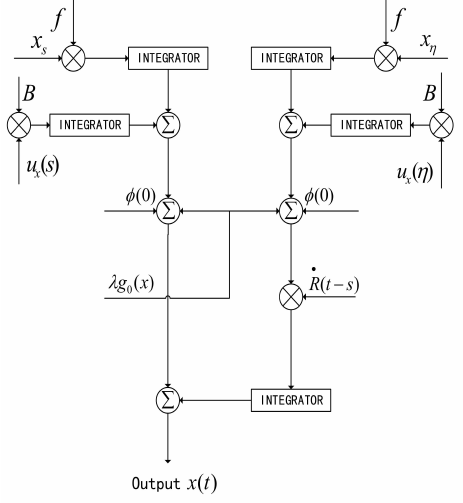
Figure 1. Filter